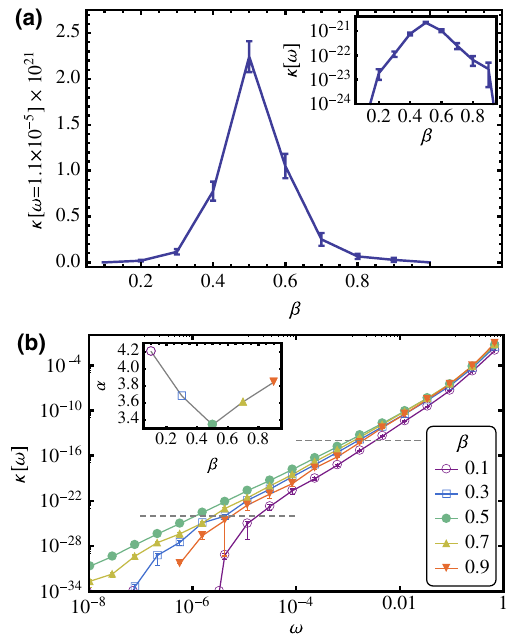
FIG. 4. (a) Low-frequency heat conductivity plotted as a function of temperature. At the phase transition, the system becomes least localized, which is associated with a cusp in the heat conductivity. Inset: Same data plotted on a log-linear scale supporting the form κ ∼ e − const j β − β c j . (b) Heat conductivity plotted as a function of frequency for five different temperatures. The low-frequency heat conductivity displays power-law scaling with frequency κ ð ω Þ ∼ ω α . Inset: α as a function of β (see text). [In all − 0 . 555 and Δ − 0 . 2 . Error bars indicate uncer- cases, δ I ¼ J 0 ¼ tainty due to disorder averaging; uncertainty due to Monte Carlo sampling is always smaller. Dashed lines in (b) indicate the region being fitted for the